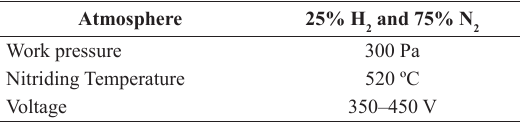
Table 3- Ion nitriding process parameters.